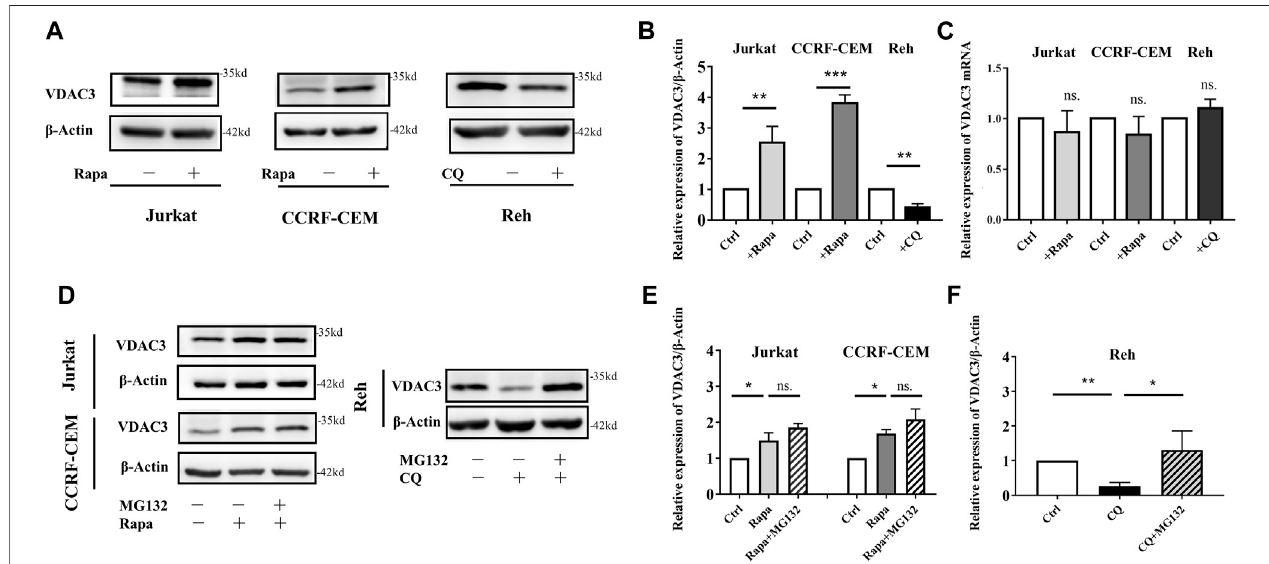
FIGURE 2 | Autophagy activation promoted VDAC3 expression via proteosome degradation in ALL cells. (A) The expression levels of VDAC3 in Jurkat, CCRF- CEM, and Reh cells after Rapa and CQ treatment. The expression of β -actin was examined as a control. (B) Histogram of the relative expression levels of VDAC3 with different treatments. (C) Histogram of the relative mRNA expression levels of VDAC3 under different treatments. (D) Cells were treated in the absence or presence of 1 μ mol/l MG132 and whole cell lysates were prepared for IB with a VDAC3 antibody. The expression of β -actin was examined as a control. (E) Histogram of the relativeexpressionlevelsofVDAC3inJurkatandCCRF-CEM cellsunderdifferenttreatments. (F) HistogramoftherelativeexpressionlevelsofVDAC3inRehcellsunder different treatments. Results are means ± SD of three independent experiments. * p < 0.05, ** p < 0.01, *** p < 0.001, ns. indicates no statistical signi fi